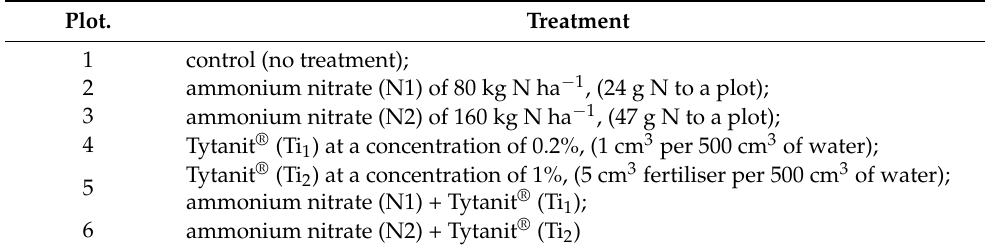
Table 1. Treatment combinations.